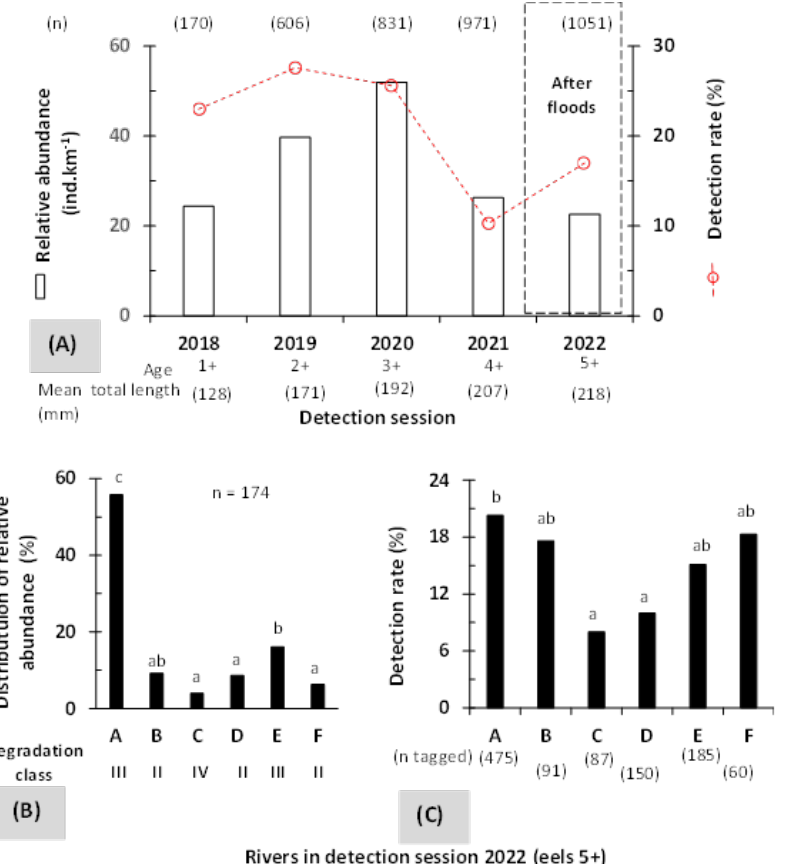
Figure 2. Development over time of the relative abundance and the detection rate of the tagged eels detected from the sessions in 2018 (1 + ) to 2022 (5 + ) ( A ). Repartition of the relative abundance ( B ) and the detection rate ( C ) of eels 5 + between rivers. ( n ) indicates the cumulative number of eels tagged during all fall electrofishing sessions performed prior to each spring detection session. Age is relative to the age of eels after restocking in 2017. The mean total length represents the cumulative total length of eels tagged since 2017 (0 + ) for each detection session. The rivers are A , B , C , D , E and F . Rivers sharing at least one common letter are not significantly different (Fisher’s exact test: p <